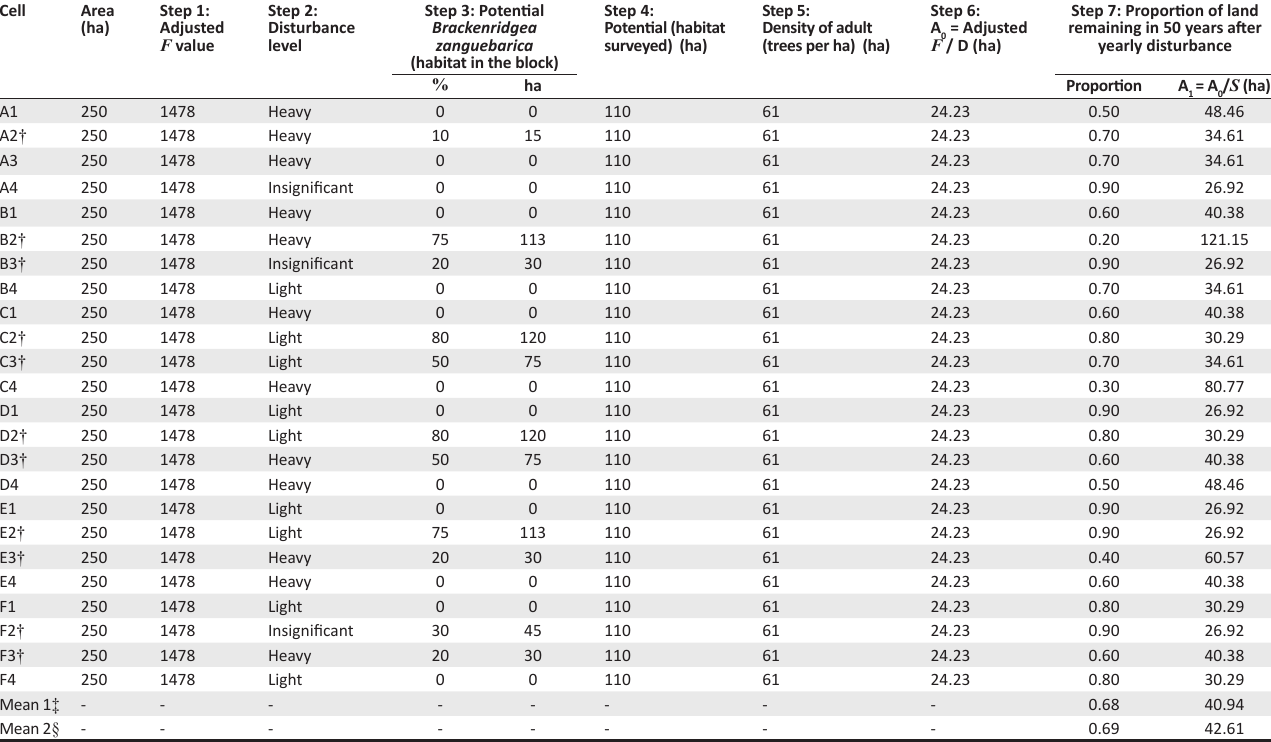
TABLE 2a: Brackenridgea zanguebarica minimum conservation area size using Burgman et al .’s method (Step 1–7): Scenario 1 – Status quo conditions. Cell Area Step 1: (ha)